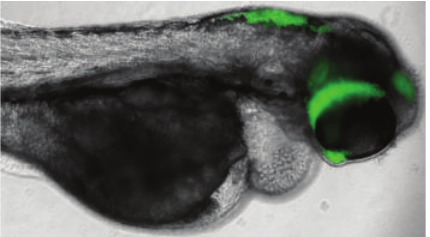
Figure 3: Zebrafish embryo 48 hours after infection with Crypto- coccus neoformans strain H99 expressing GFP. Image Courtesy of